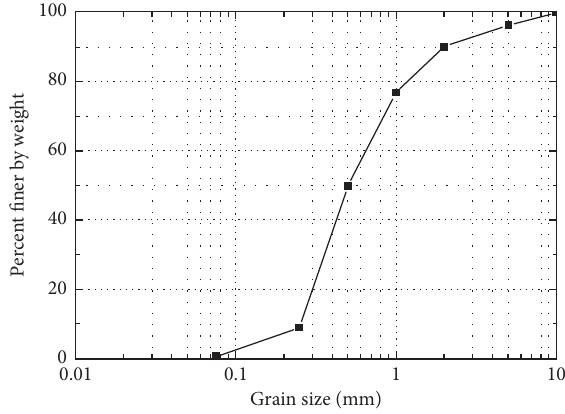
Figure 3: Grain size distribution